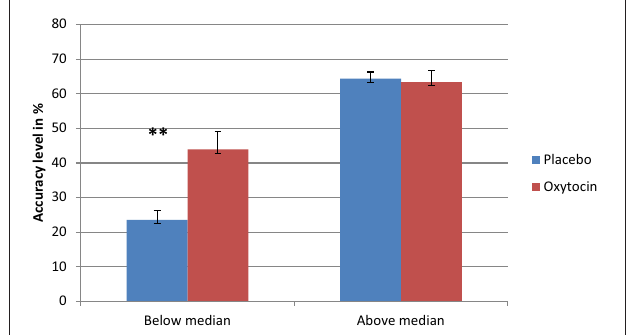
FIGURE 2 | Separate paired t -tests reveal that participants whose basic fear recognition ability was below the median were significantly improved in fear recognition following OT administration, as opposed to their performance following placebo administration ( ∗∗ ). Conversely, participants whose basic fear recognition ability was above the median did not exhibit any significant difference between their OT performance and placebo performance ( ∗∗ p < 0 .